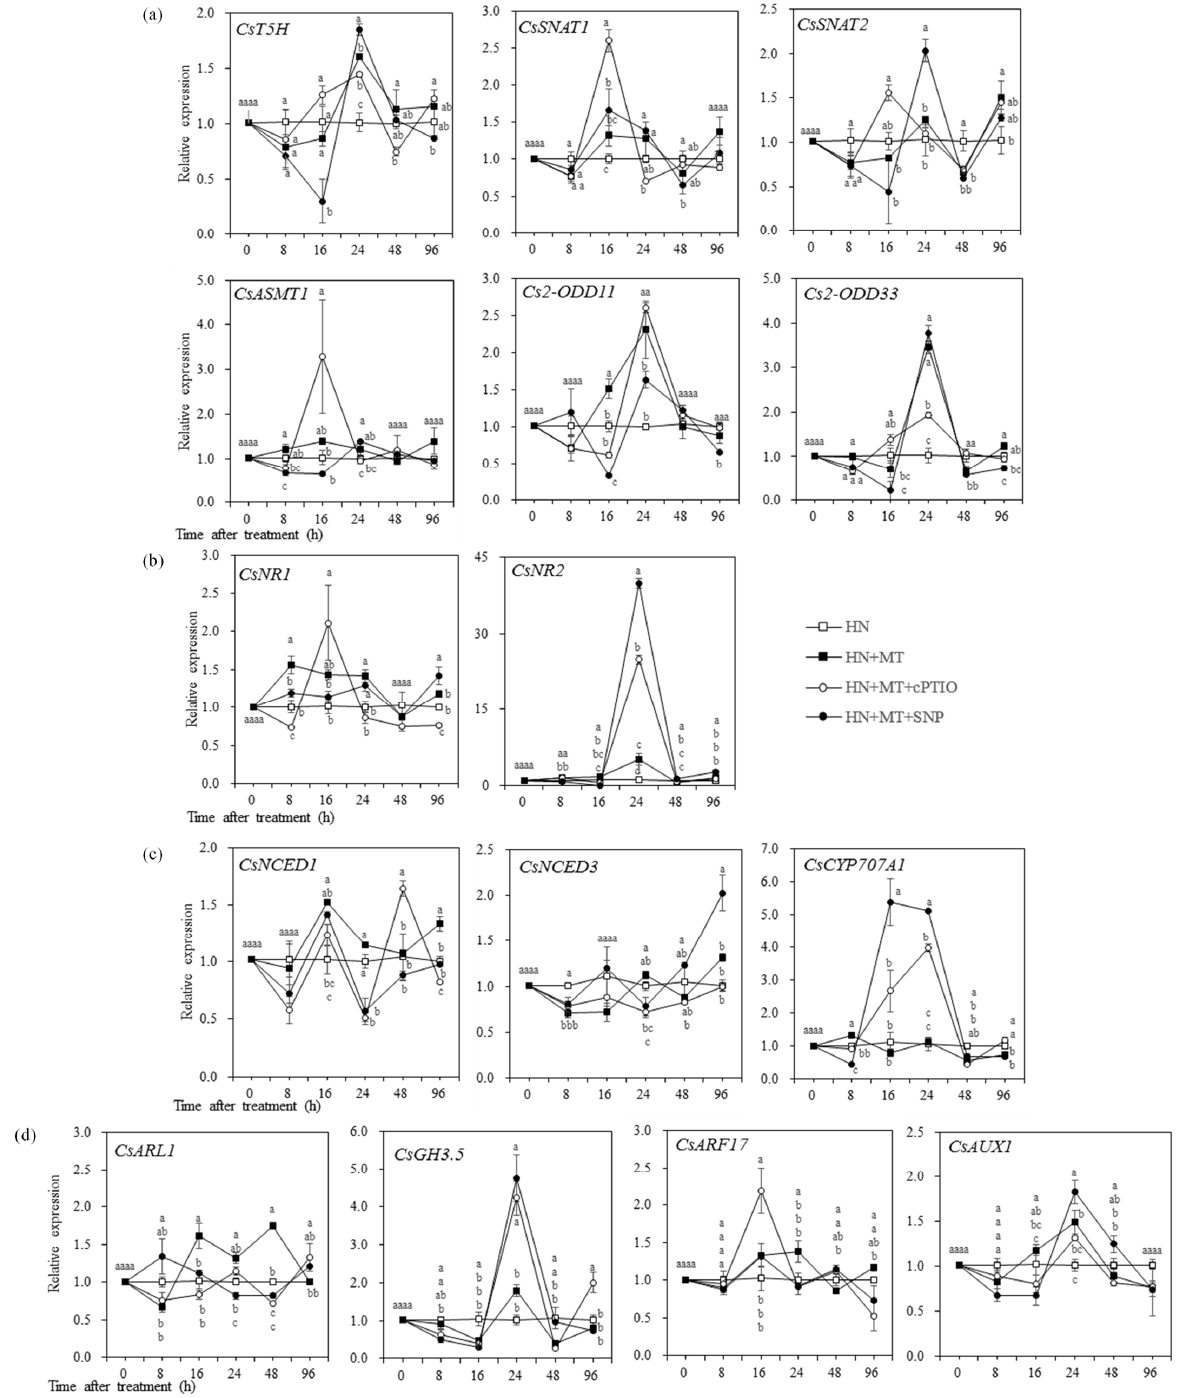
Figure 7. Effects of MT and NO treatments on expression of genes involved in MT metabolism ( a ), Nitrogen metabolism ( b ), ABA metabolism ( c ), Root growth and IAA transport ( d ) in roots of cucumber seedlings. Error bars represent standard deviations of the means of three independent replicates. Different letters indicate significant differences between treatments by Duncan’s multiple range test ( p <